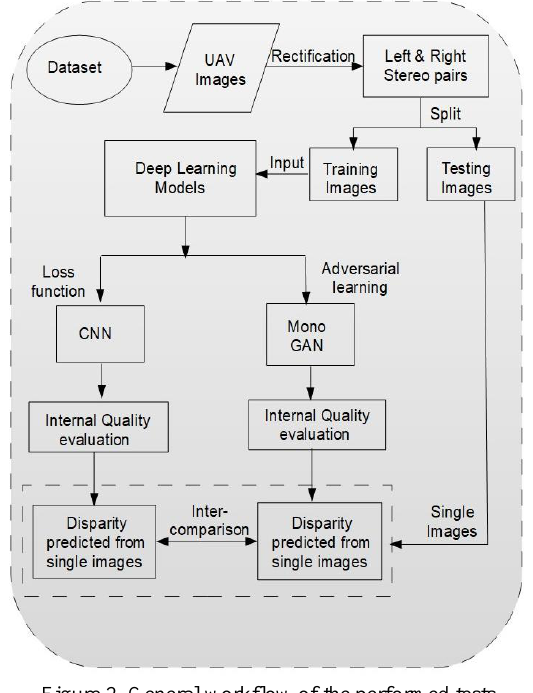
Figure 2. General workflow of the performed tests To begin with, the UAV images are pre-processed to generate left-right stereopairs. The single image depth estimation problem is treated as an image reconstruction problem, using the encoder- decoder deep CNN model. The model takes only the left image from the stereo pair to produce disparity, which is warped with the right image through bilinear sampling to reconstruct the left image. The difference between the reconstructed left image and the input left image is calculated as a loss. The model backpropagates the loss and learns to produce better disparity from the single left image. This is the general approach of the deep learning models used in this study for learning disparity in trained using the dataset to produce disparity from single image.